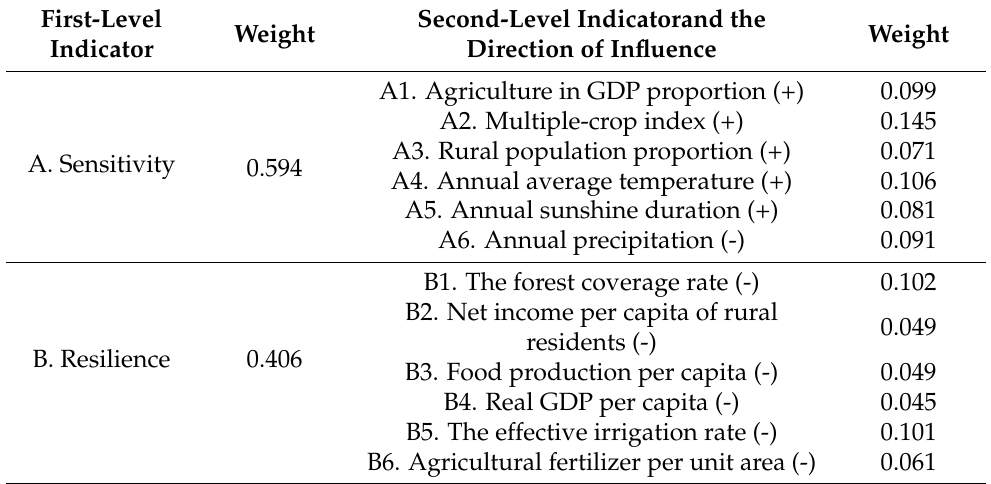
Table 3. The weight of each indicator.